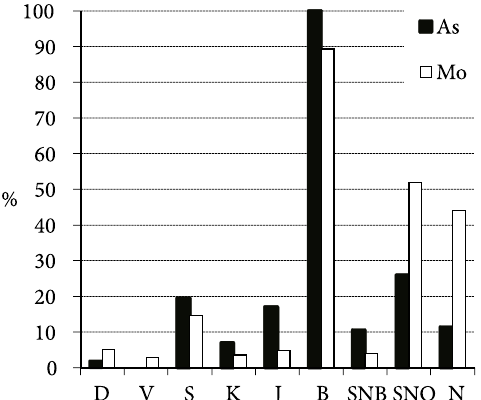
Fig. 3. Percentage of samples where MPC of As and Mo is exceeded in different sections. Outcrops: D – Daumantai, S – Šlavė, B – Butėnai, SNO – Snaigupėlė, N – Netiesos.